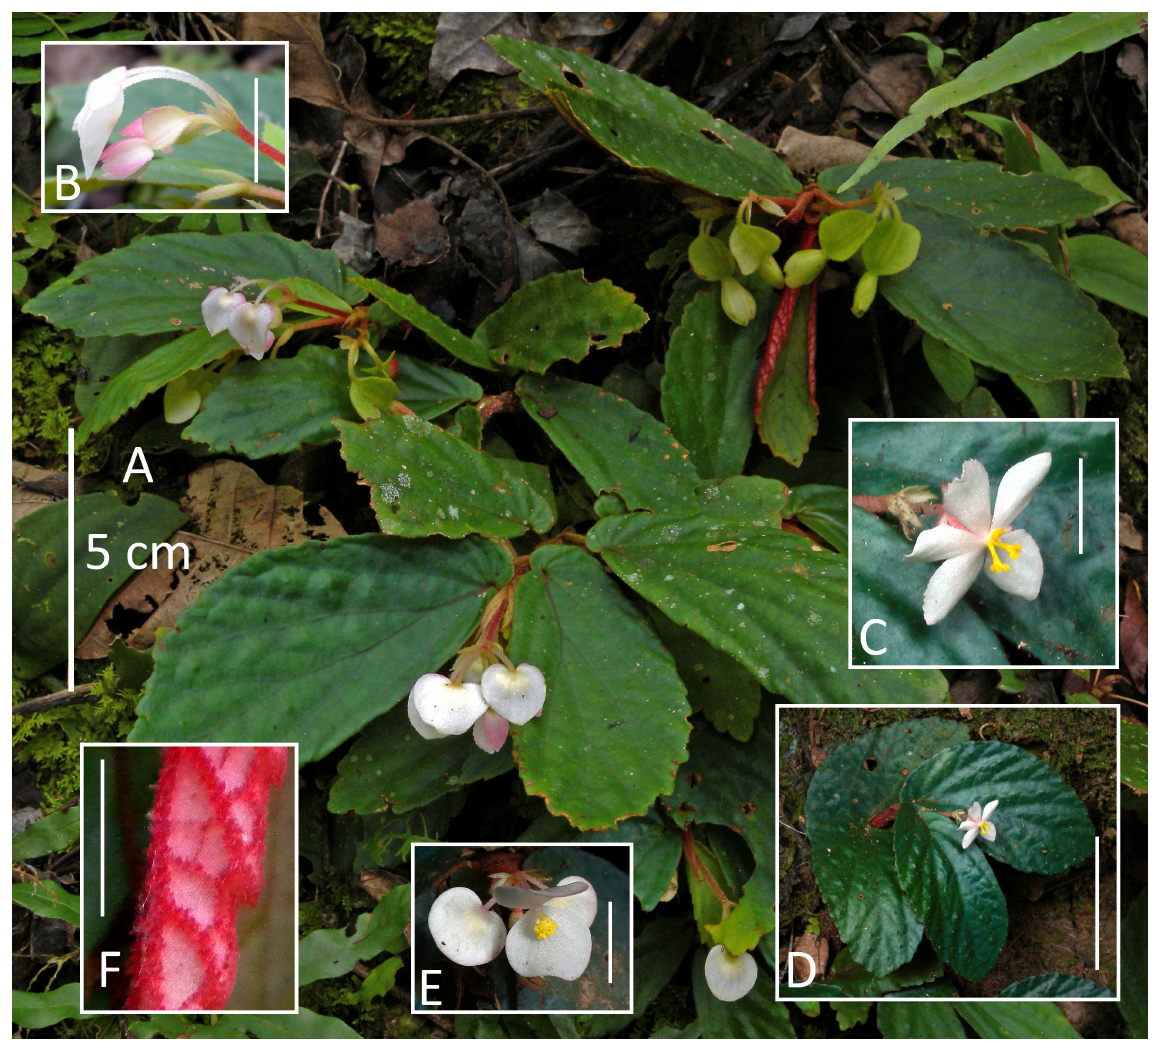
Fig 1. Begonia beludruvenea M.Hughes sp. nov. A . Habit. B . Inflorescence with two male flower buds and two female buds beneath. C . Female flower. D . Habit showing blue iridescence. E . Male flower. F . Underside of leaf margin showing red hairs. C–E from Bukit Sebelah, Hughes & Taufiq MH1549A ; A, B, F from Bukit Sebelah, Hughes & Taufiq MH1541 . Scale bars on insets: B, C, E, F = 1 cm; D = 5